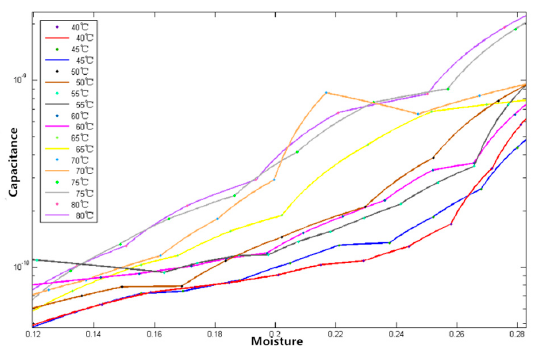
Figure 4. Moisture dependence of capacitance at a temperature range of 40 to 80 °C at 2 kHz.